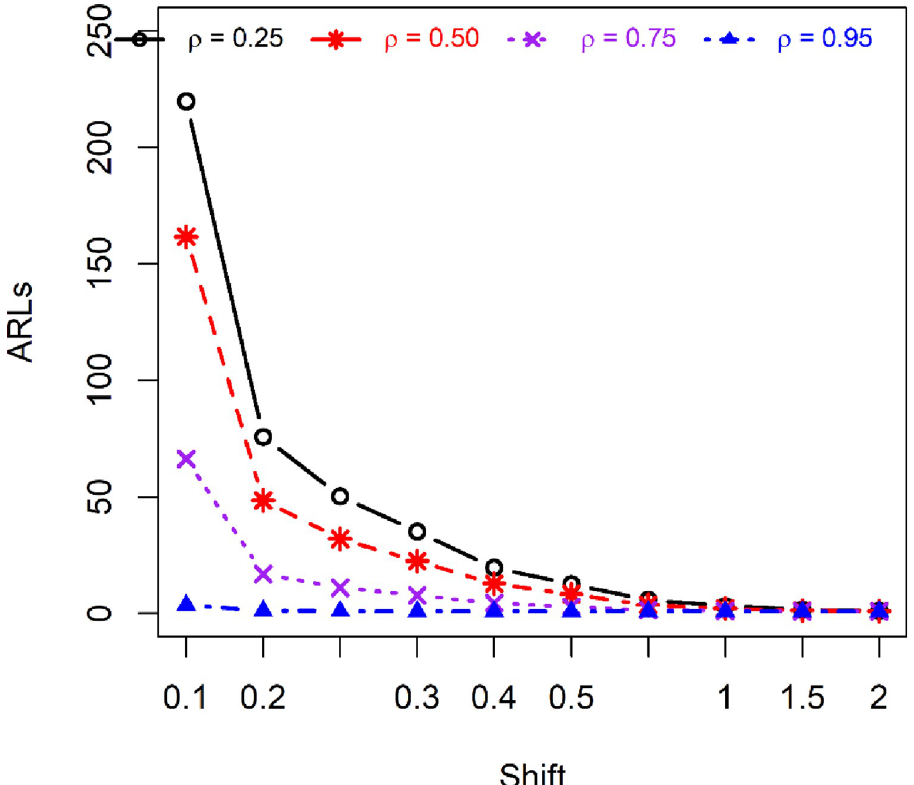
Fig 3. ARL profile of proposed IAEWMA AIB control chart under different ρ for ( λ 1 , λ 2 ) = 0.10 at ARL 0 = 500.